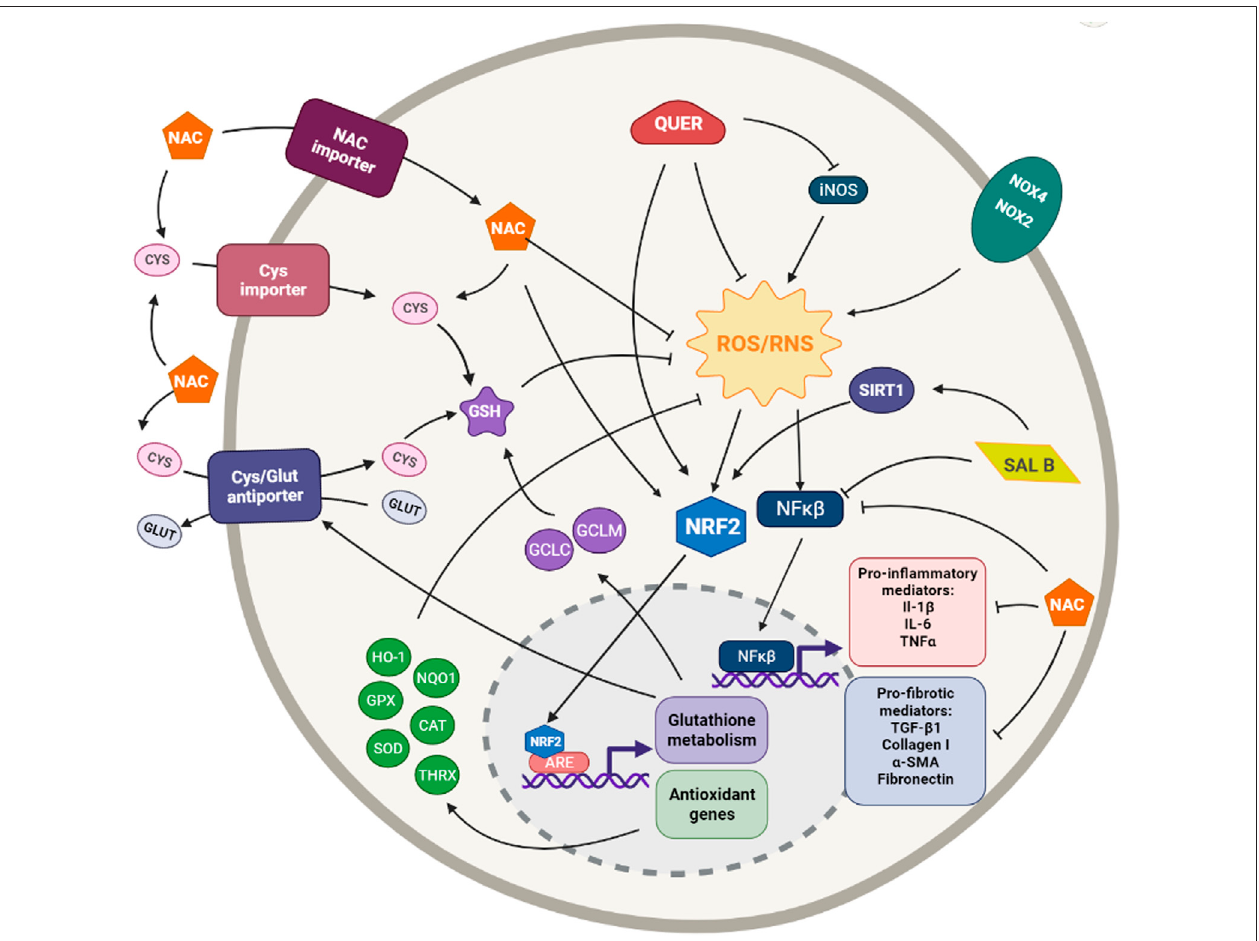
FIGURE2| Simpli fi eddiagram oftheprincipalmolecularmechanismsoftheantioxidant enhancers n-acetylcysteine(NAC), Quercetin (QUER)andSalvianolicacid B (SAL B). α SMA: alpha smooth muscle actin; ARE: antioxidant responsive element; CAT: catalase; CYS: cysteine; GCLC: glutamate cysteine ligase catalytic subunit; GCLM: glutamate cysteine ligase modi fi er subunit; GLUT: glutamate; GPX: glutathione peroxidase; GSH: glutathione; HO-1: heme oxygenase 1; IL-1 β : interleuquina 1beta; IL-6: interleuquina 6; iNOS: inducible nitrogen oxide synthase; NF κβ : nuclear factor kappa beta; NOX1,2,4: NADPH oxidases; NQO1: NAD(P)H:quinone oxidoreductase 1; NRF2: nuclear factor erythroid 2-related factor 2; ROS/RNS: reactive oxygen species/reactive nitrogen species; TGF- β 1: transforming growth factor beta 1; TNF α : tumoral necrosis factor alpha; SIRT: sirtuine 1; SOD: supeoxide dismutase Created with Biorender.com.